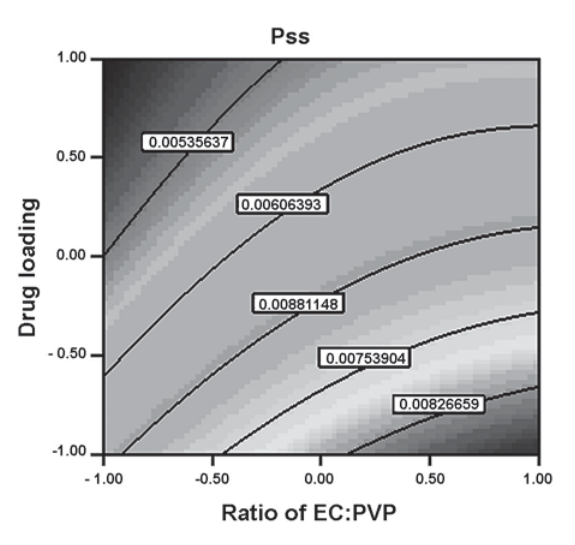
) indicat- Figure 9 – Response surface plot for permeability coefficient SS (P ) indicating the effect of the ratio of EC: PVP and drug SS SS loading on P . SS